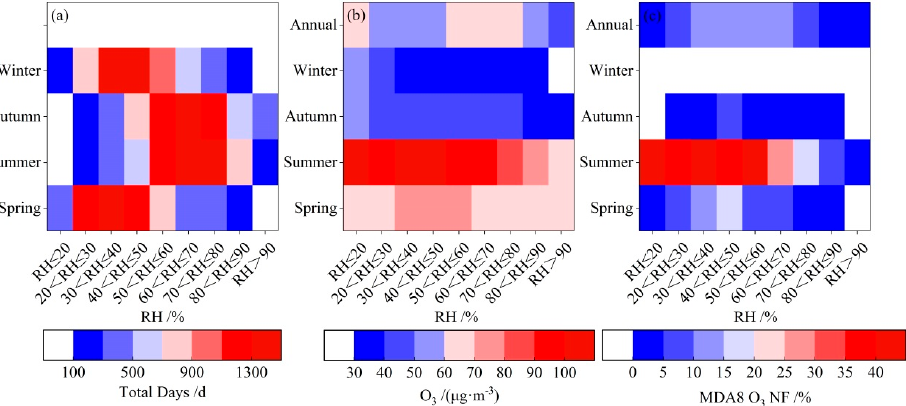
Figure 10. Variations in the total days ( a ), mean O 3 mass concentration ( b ) and MDA8 O 3 nonattainment frequency (NF), ( c ) corresponding to different relative humidity ranges in each season and year.